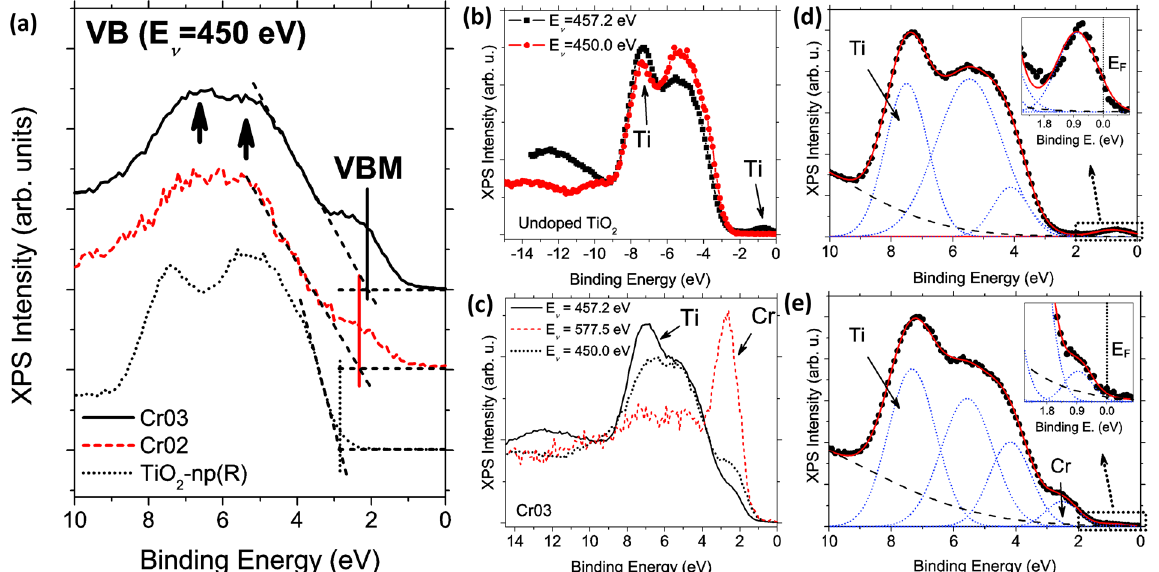
Figure 7. ( a ) VB-XPS spectra from undoped (TiO 2 -np(R)) and Cr doped TiO 2 with different Cr concentration (Cr02, Cr03) using a photon energy E ν = 450 eV. The dashed lines are indicative for the estimation of the VBM. ( b ) On and off-resonance BV spectra from undoped TiO 2 and ( c ) Cr-doped TiO 2 microtubes (Cr03). Arrows in ( b ) and ( c ) mark the resonant peaks according to the absorption maximum selected. ( d ) Gaussian deconvolution (straight line) of Ti resonant XPS spectra (dots) measured with a photon energy of 457.2 eV for TiO 2 -np sample, and ( e ) Cr doped TiO 2 (Cr03). The insets in ( d ) and ( e ) correspond to enlargement of the E F